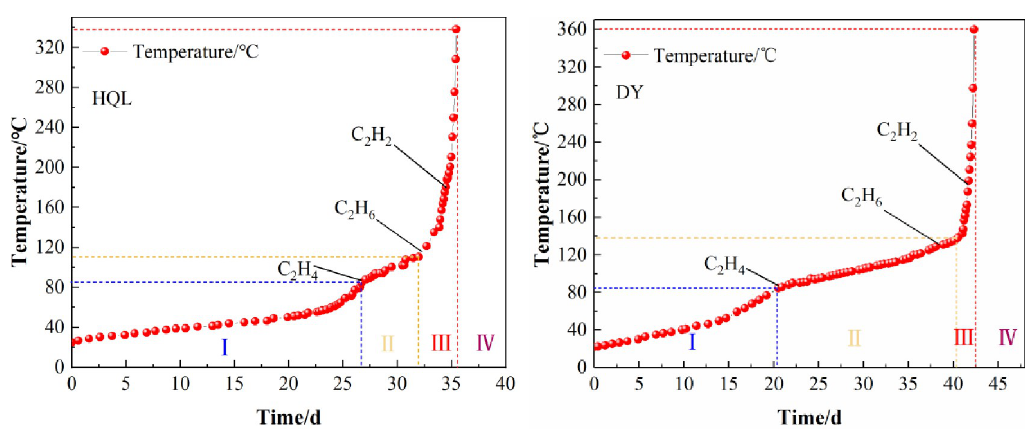
Fig 7. Upward trend of coal spontaneous